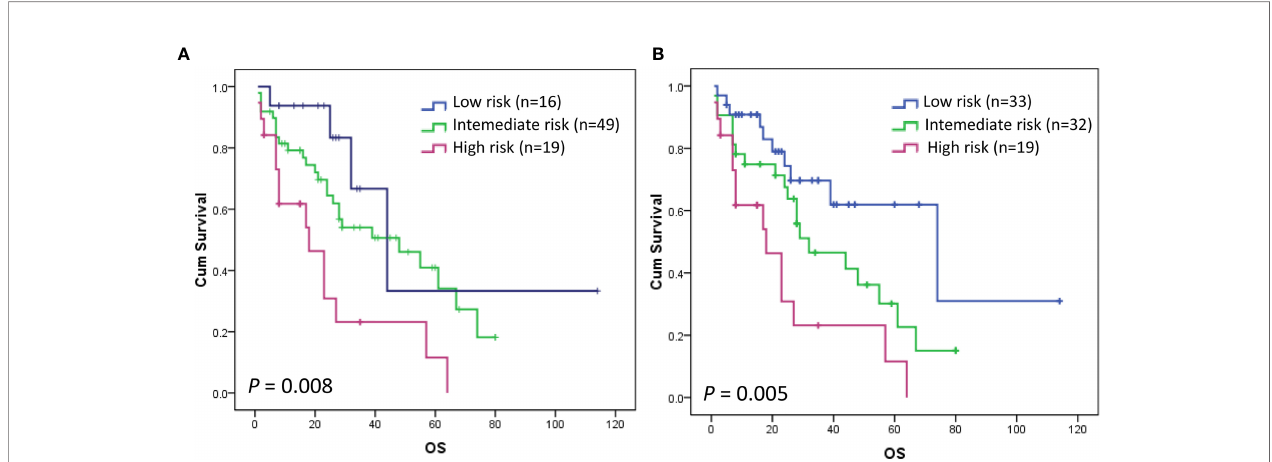
FIGURE 4 | Kaplan – Meier curve for OS according to the MSKCC scoring system (A) and PCNSL LLR scoring system (B) in the validation cohort. The OS rates of patients in the low-, intermediate-, and high-risk groups of the MSKCC scoring system were signi fi cantly different overall, with 5-year OS rates of 33.3% (n = 16) and 40.9% (n = 49), and 11.6% (n = 19), respectively ( P = 0.008). MSKCC scoring system could not discriminate patients within low-, and intermediate- groups in the validation cohort ( P = 0.243) (A) . PCNSL LLR scoring system can clearly distinguish patients within the low-, intermediate-, and high-risk groups in the validation cohort ( P = 0.005) (B)